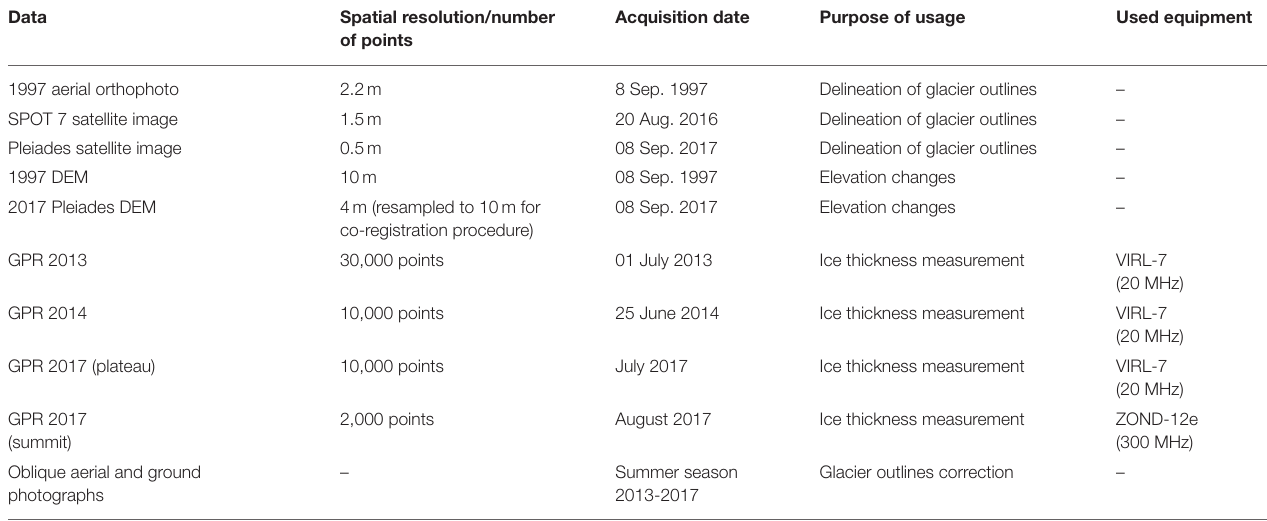
TABLE 1 | List and characteristics of used